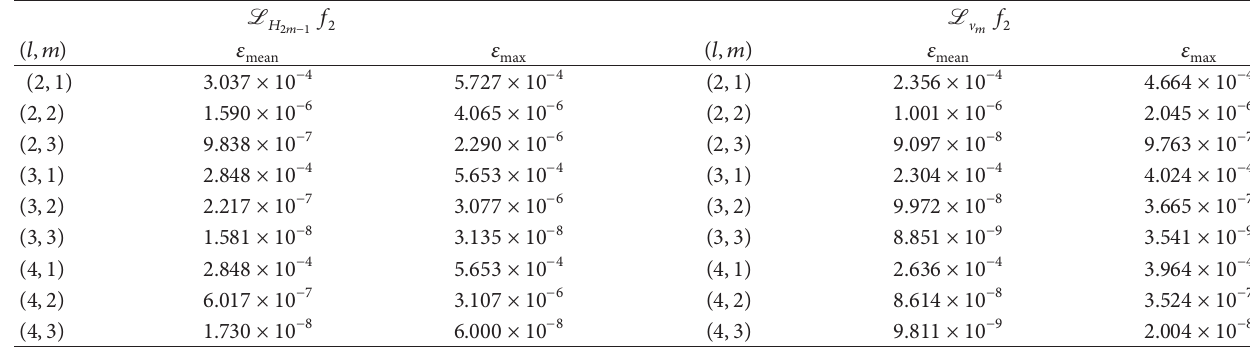
and L V for the sphere function. 2𝑚−1 𝑚